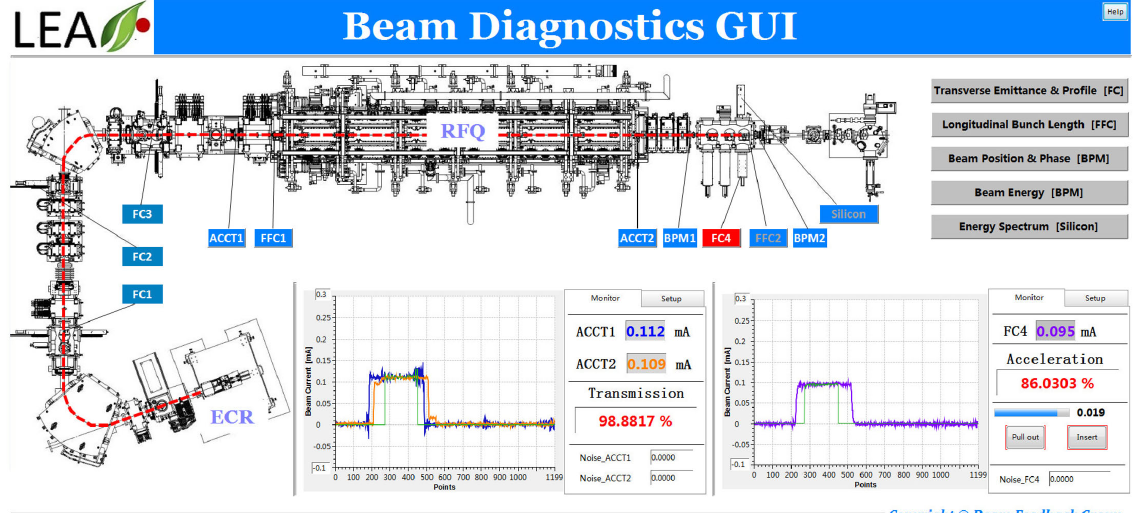
26. Interface of the beam